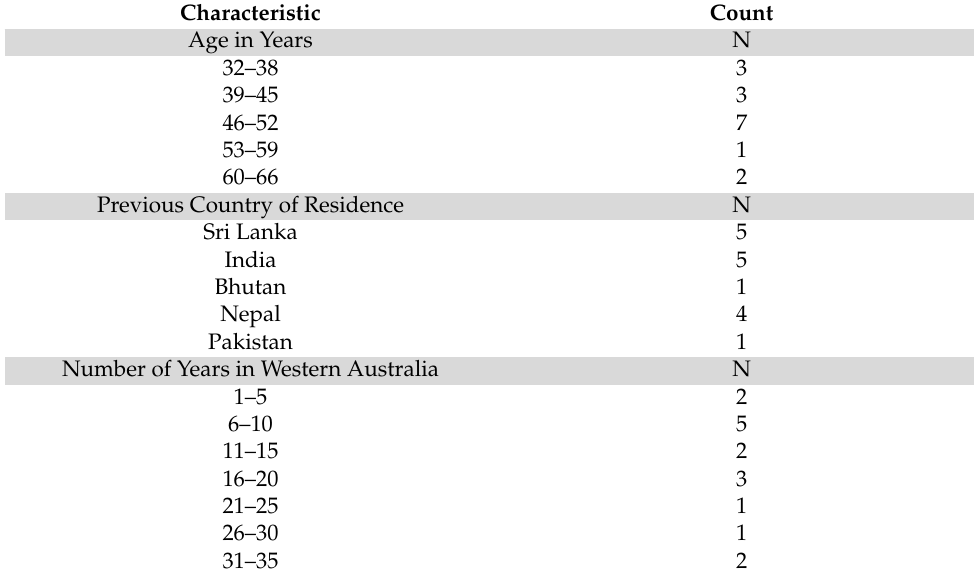
Table 1. Demographic characteristics of study